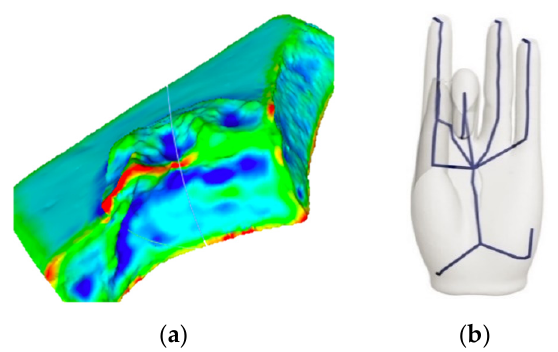
Figure 2. ( a ) The sharp features of a cultural relic fragment. ( b ) The skeleton line can show the basic geometry of the hand and the topological relationship between the fingers.